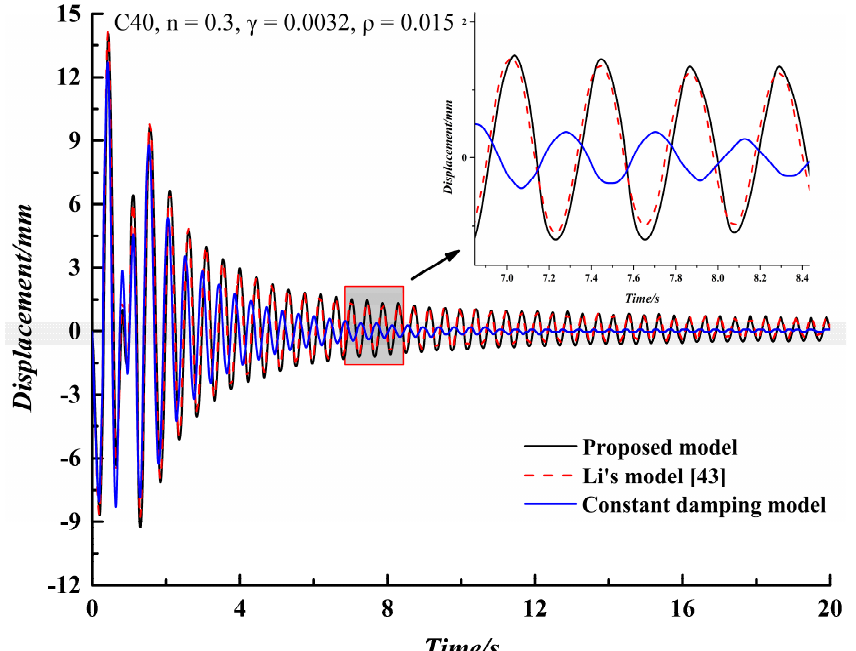
Figure 10. The column head displacement response of FRP-C RC columns with rectangular section under biaxial harmonic load (C40, n = 0.3, γ = 0.0032, ρ = 0.015).